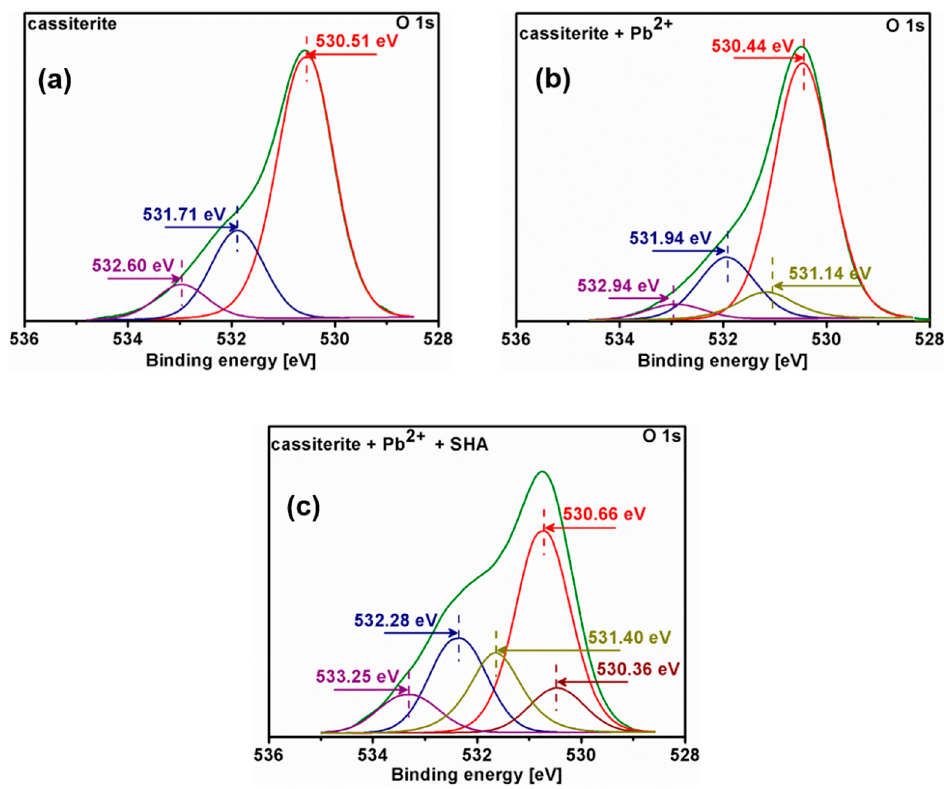
Figure 10. O 1s XPS spectra recorded from the surfaces of pure cassiterite ( a ) in the presence of Pb 2+ ( b ) and Pb 2+ and SHA ( c ).